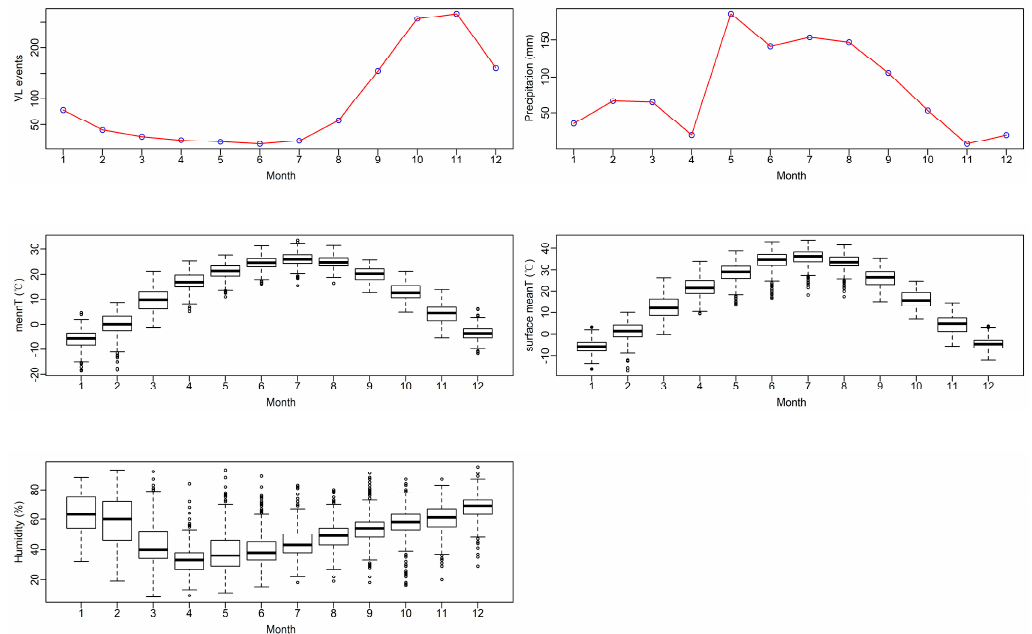
Figure 3. Monthly characteristics of VL events and meteorological factors. The first two panels are average values of monthly VL events and precipitation, and the other three panels are boxplots of monthly mean temperature, monthly mean surface temperature, and relative humidity.